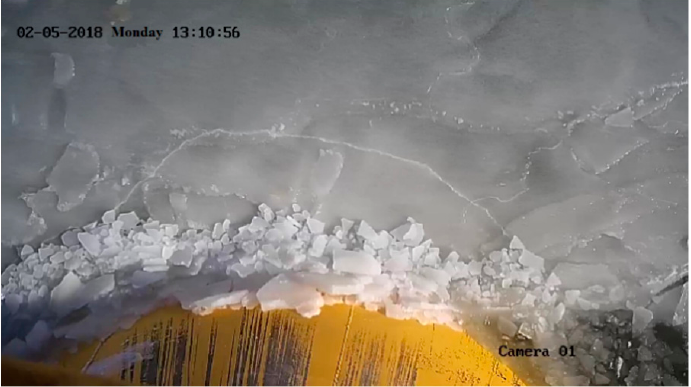
Figure 14. Bending failure phenomenon of ice on a conical OWT. From the above analysis of ice periods and ice amplitudes, the random ice force of a conical OWT can be established. Based on the Monte Carlo method, a time history simulation of random ice forces on a conical OWT using the MATLAB software (Figure 15b) was conducted; the ice force time history data were applied to the ANSYS FEM of the OWT to analyze the structural response. An acceleration sensor was located in the tower and 14 m from the top of the foundation (Figure 15a). The acceleration response data of the structure corresponding to the sensor placement point in the FEM were